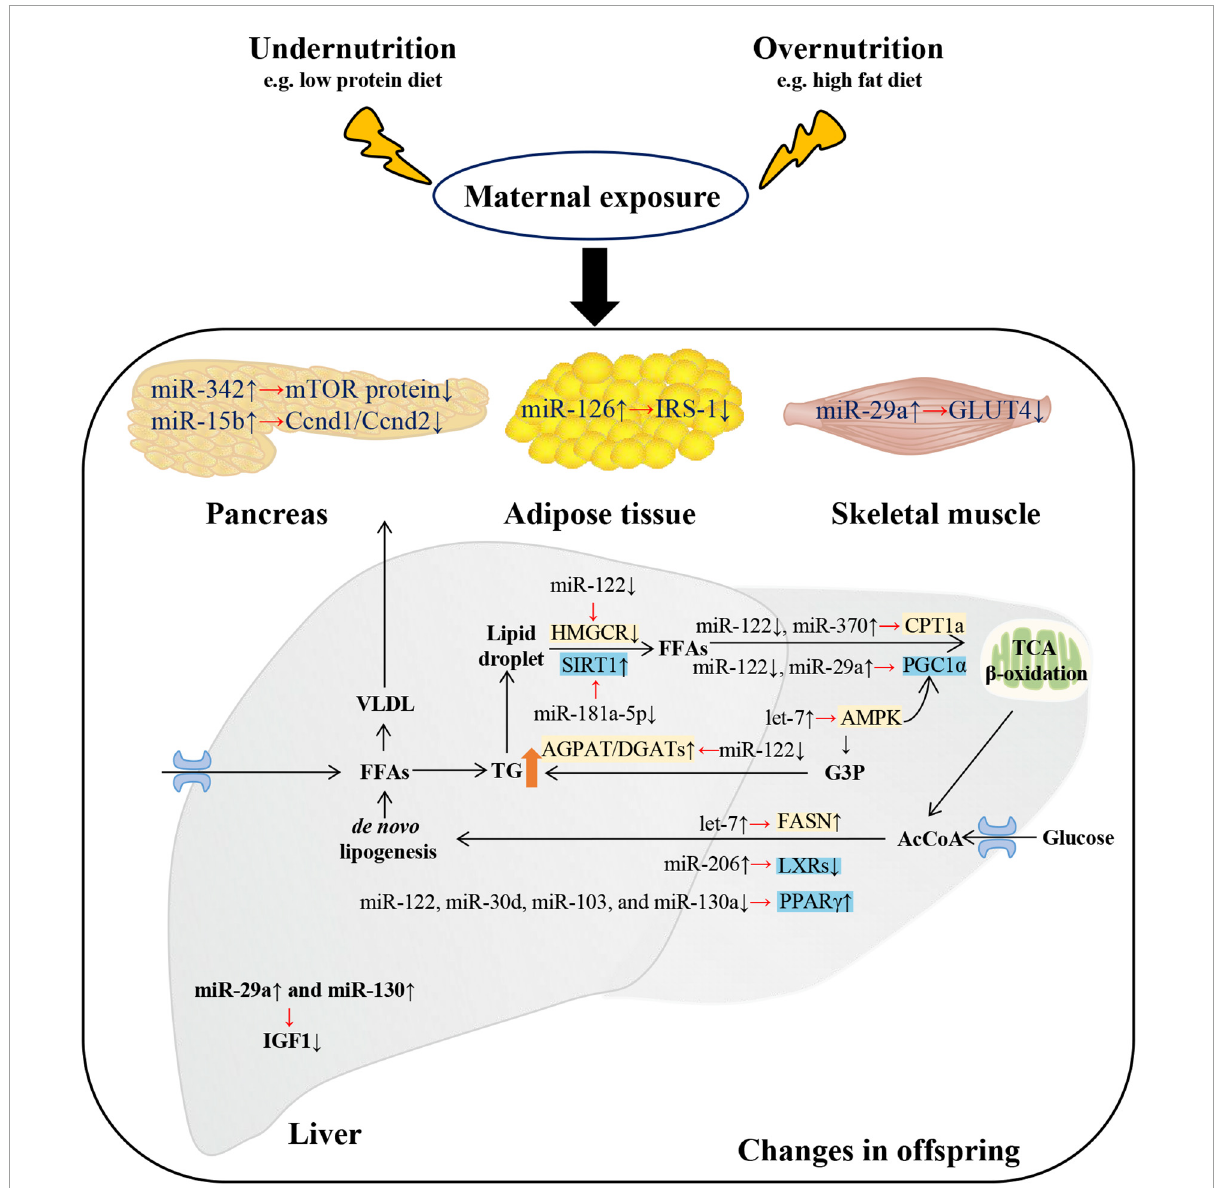
FIGURE1 Changes and putative targets of microRNAs (miRNAs) on metabolism-related tissues of metabolic syndrome of offspring exposed to maternal malnutrition. Metabolic disturbances in offspring exposed to maternal malnutrition were regulated by miRNAs. Disorders of glucose metabolism mainly involved four tissues: liver, pancreas, adipose tissue, and skeletal muscle. In the liver of offspring exposed to maternal fructose intake, the increase of miR-29a and miR-130 resulted in the decrease of hepatic insulin-like growth factor-1 (Igf1) mRNA and protein expression. In pancreas of offspring exposed to maternal low protein diet, the decline of cyclin D1 (Ccnd1)/cyclin D2 (Ccnd2) and mTOR protein levels were due to the rise of miR-15b and miR-342 respectively. In white adipose tissue of mice offspring exposed to maternal HFD-induced obesity, the insulin receptor substrate 1 (IRS-1) was decreased by miR-126. In the skeletal muscle of IUGR rat, the increase of miR-29a resulted in the decrease of glucose transporter 4 (GLUT4). As for lipid metabolism, it mainly involved liver tissue. Free fatty acids (FFAs) produced from white adipose tissue and dietary sources can enter hepatocyte. And FFAs are usually esterified to triacylglycerol (TG) and then packaged as VLDL (very low-density lipoprotein) for export or stored as intracellular lipid droplets. MicroRNAs regulate the hydrolysis of TG back to FFAs and then into the process of mitochondrial β -oxidation (by regulating various coactivators or nuclear receptors such as sirtuin-1 (SIRT1), PPAR γ co-activator 1 α (PGC1 α ), and genes such as CPT1a (carnitine palmitoyltransferase 1a). In addition, miRNAs promoted de novo lipogenesis by regulating genes (such as Fasn) and transcription factors [such as liver X receptors (LXRs) and peroxisome proliferator-activated receptor γ (PPAR γ )]. The overall metabolic trend is TG accumulation and hyperglycemia. G3P, glycerol-3-phosphate; AGPAT, acyl-CoA